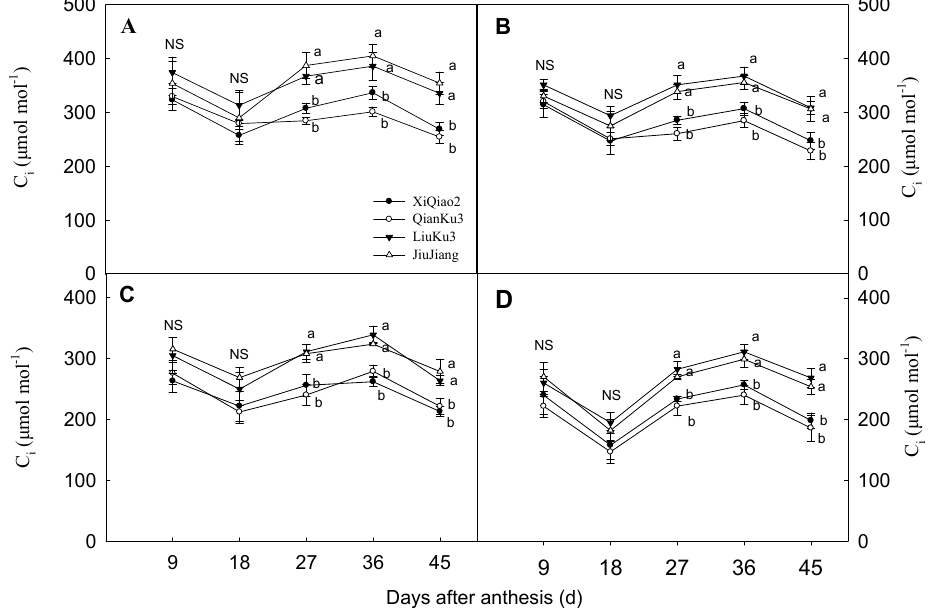
Figure 5. Intercellular CO 2 concentration (C i ) in the leaves of four Tartary buckwheat cultivars at different flowering nodes. Panels ( A – D ) show results for the leaves of the 6th, 7th, 8th, and 9th flowering nodes, respectively. Data are the means ± SD of two years (2016 and 2017). Letters a and b denote significant differences between cultivars (p < 0.05) in G S at the same day after anthesis. NS: no significant